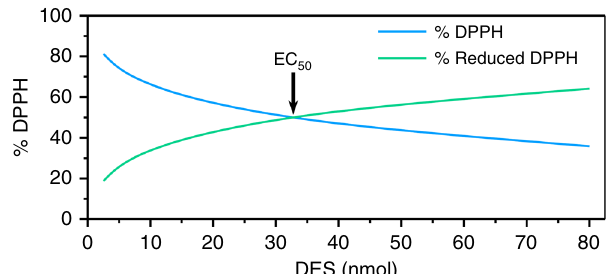
Fig. 5 Determination of the antiradical activity of DES. The determination of the antiradical activity of DES has been determined via 2,2-diphenyl-1- picrylhydrazyl (DPPH) assay. These tests involve adding DES solution in ethanol at different concentration to homogeneous DPPH solution. The EC 50 , i.e. the amount of DES needed to reduce the initial number of DPPH free radicals by half, is provided by the crossing point of % DPPH (blue) and % reduced DPPH (green), which occurs at 32.7